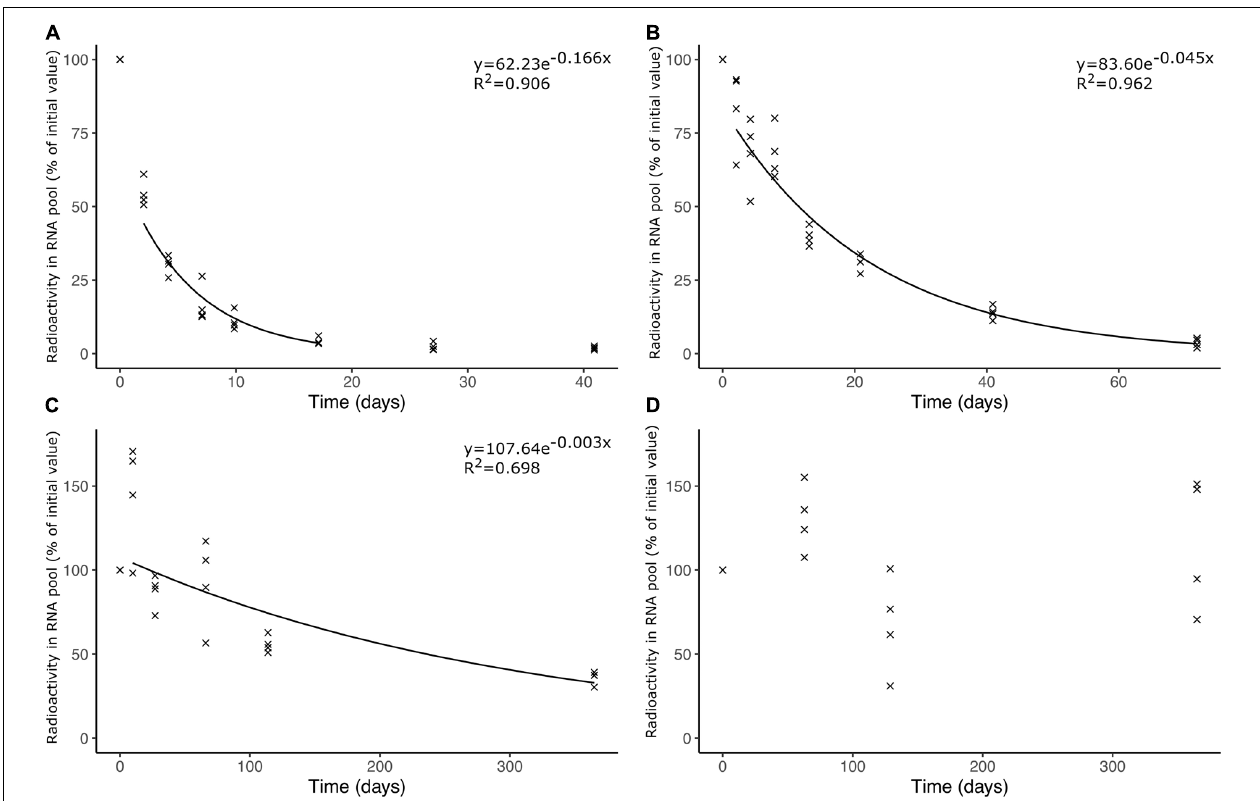
FIGURE 1 | Radioactivity in RNA isolated from soil samples incubated at different temperatures. The samples were amended with soil bacteria pre-incubated with 14 C-uridine normalized to the total amount of RNA isolated from individual samples. The soil samples were incubated at (A) 20 ◦ C, (B) 4 ◦ C, (C) –4 ◦ C, and (D) –18 ◦ C. Trend lines in (A–C) represent the average radioactivity of replicate samples and depict the time span with exponential decrease in radioactivity presumed to be related to rRNA turnover.